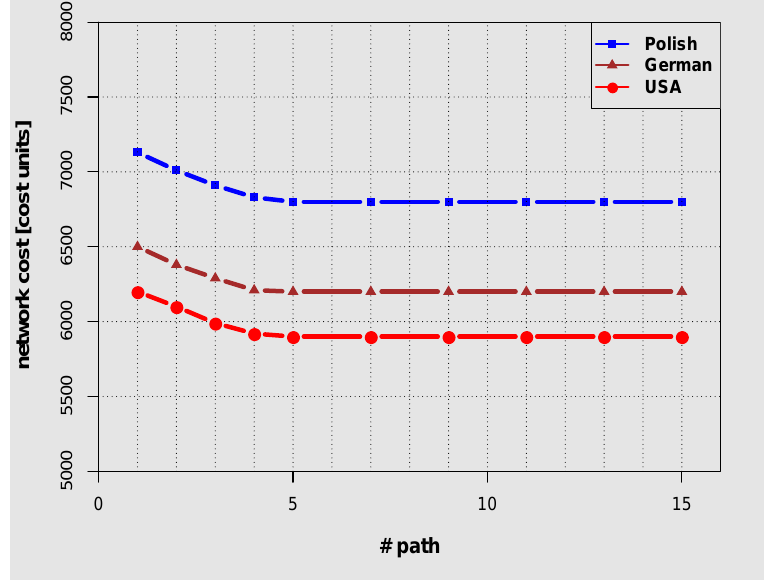
Figure 6. The dependence of network cost on the number of paths for Polish, American and German networks.